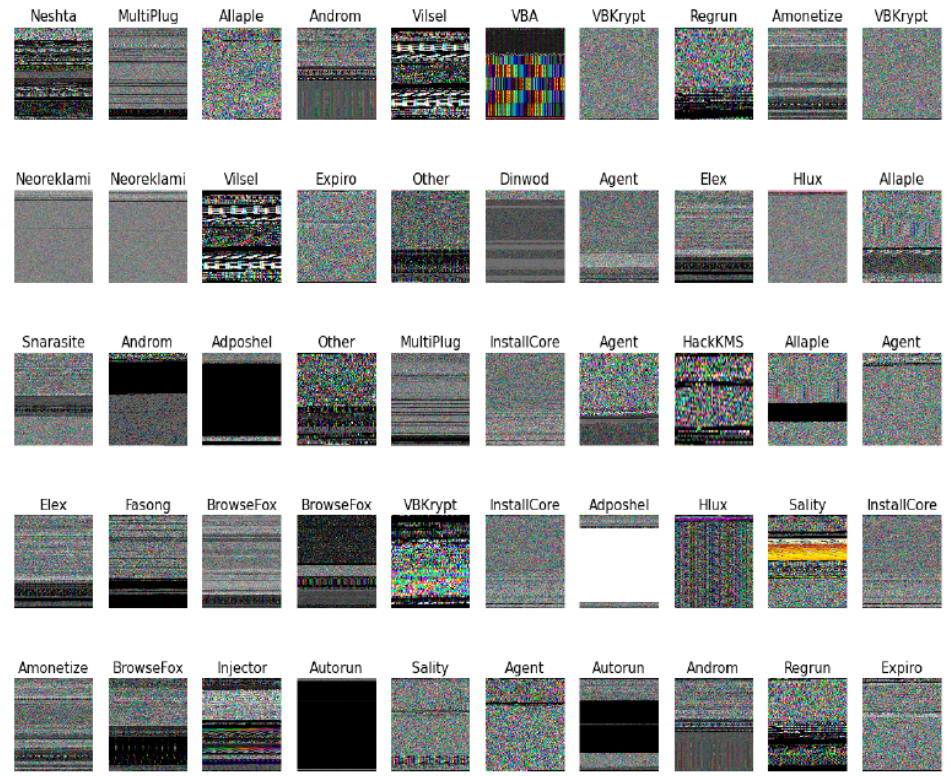
Figure 7. Various Samples collected from the MaleVis Dataset [36].